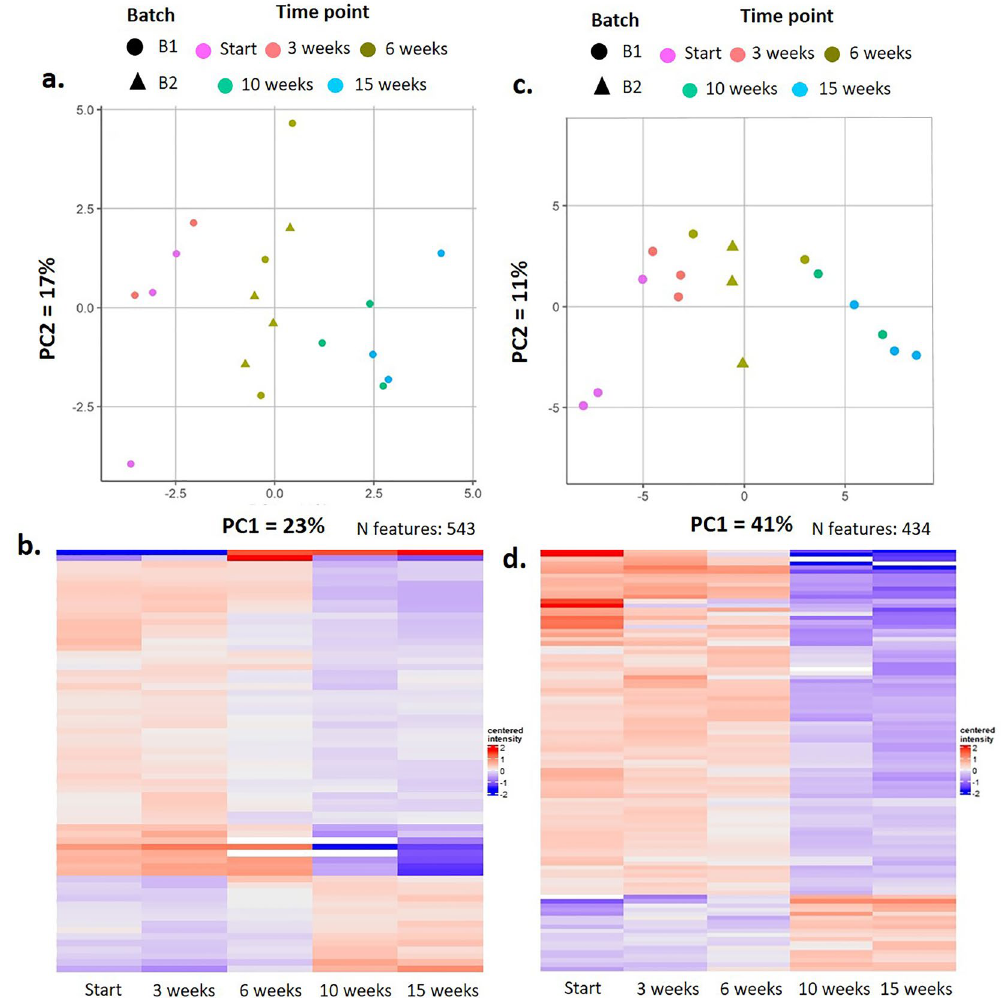
Figure 4. Proteomic analyses of D. immitis infected NSG mouse tissues. Principal component analyses (PCA) of plasma ( a ) and urine ( c ) illustrate changes in the proteome over time that are consistent within and between batches of mice and larva. Heat maps of the 28 proteins significantly altered in plasma ( b ) and 57 proteins significantly altered in urine ( d ) recapitulate the PCA analyses, displaying distinct proteomes at progressive timepoints in the infection. A general feature appears to be a downward trend in protein expression across plasma and urine as infection